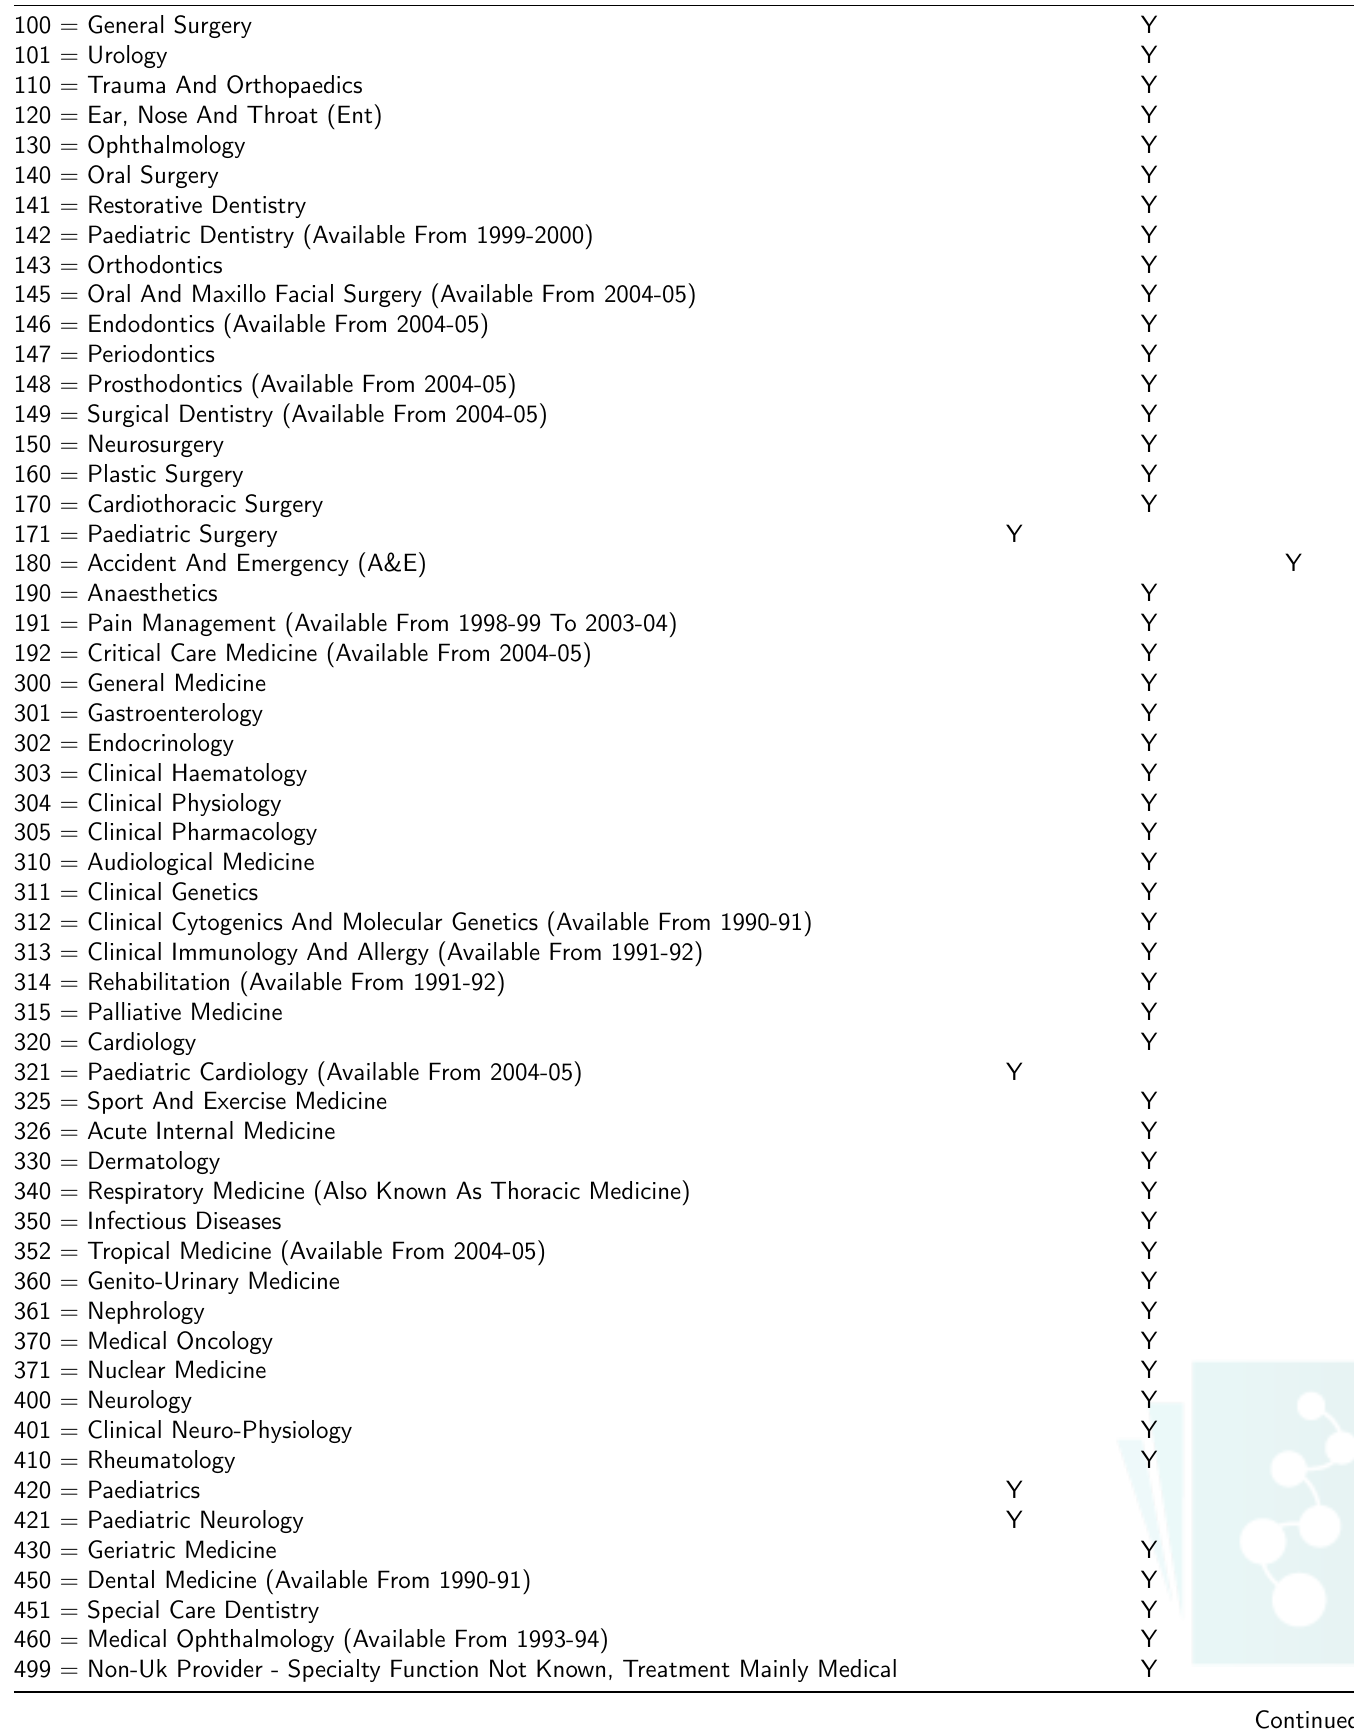
Supplementary table 2: Classification of consultant main specialties as paediatric, adult or unclassified Consultant main